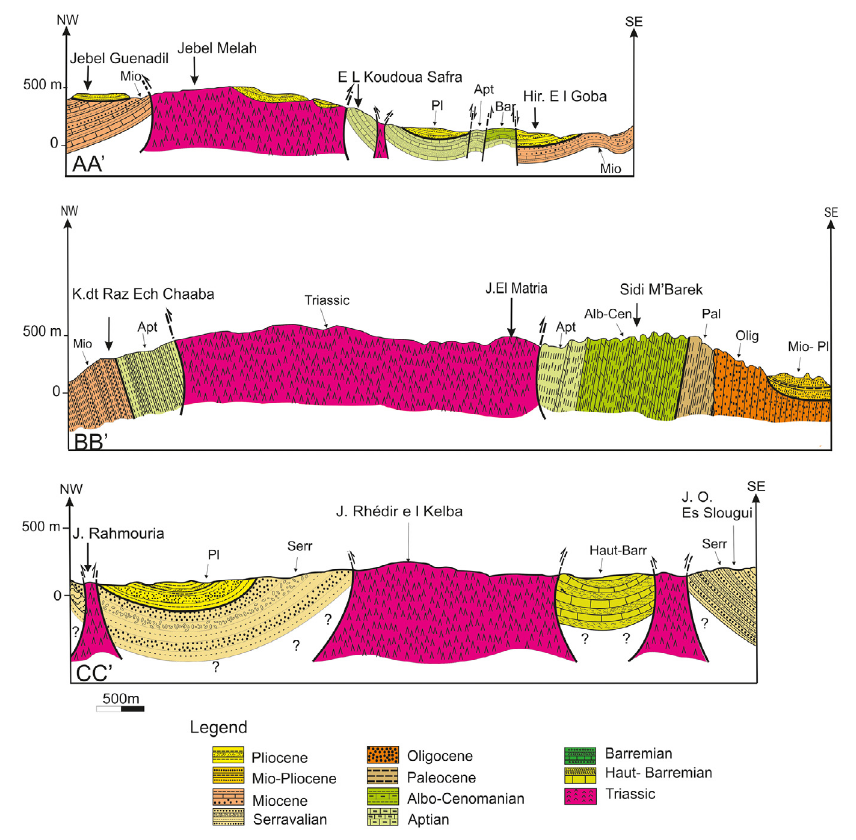
Figure 4. Structural outcropping sections at Jebel Melah (AA'), Jebel Matria (BB') and Jebel Rhédir El Kelba (CC') in the Thibar area of north- ern Tunisia. These sections show contacts of the Thibar Triassic evaporites with adjacent Mesozoic and Cenozoic strata (section locations are shown on Figure 1).